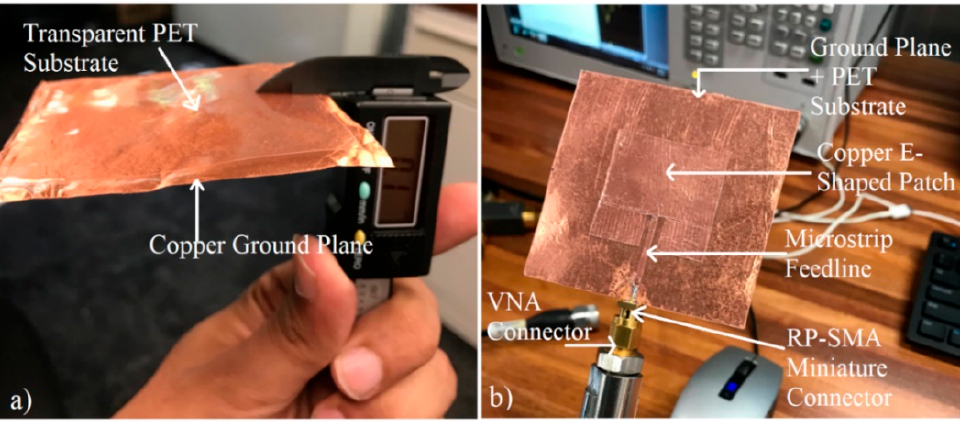
Figure 6. E-Shaped flexible microstrip patch antenna on PET substrate: ( a ) thickness measurement, ( b ) fabricated antenna connected to